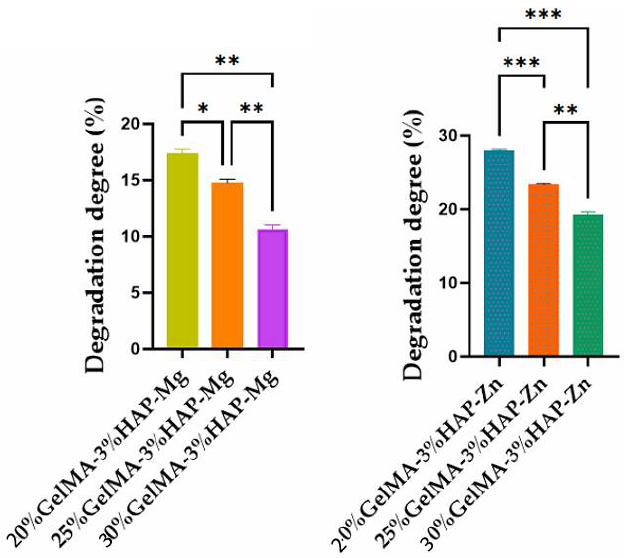
Figure 11. Degradation degree of GelMA-inorganic filler. Statistical significance: *** p < 0.001, ** p < 0.01, and * p < 0.1.